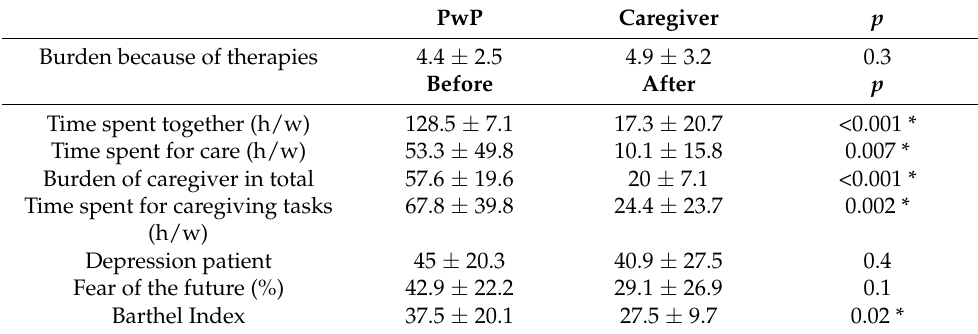
Table 2. Comparison of patient and caregiver characteristics before and after